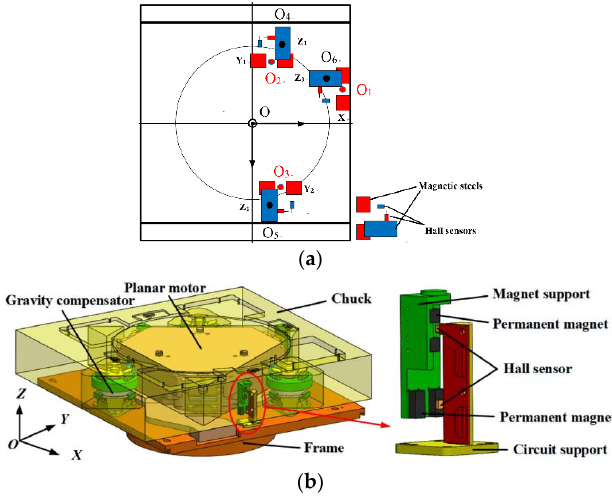
Figure 1. Schematic and structural diagram of short stroke (SS) stage with a six DOF Hall sensor displacement measurement system: ( a ) schematic diagram; ( b ) structural diagram.